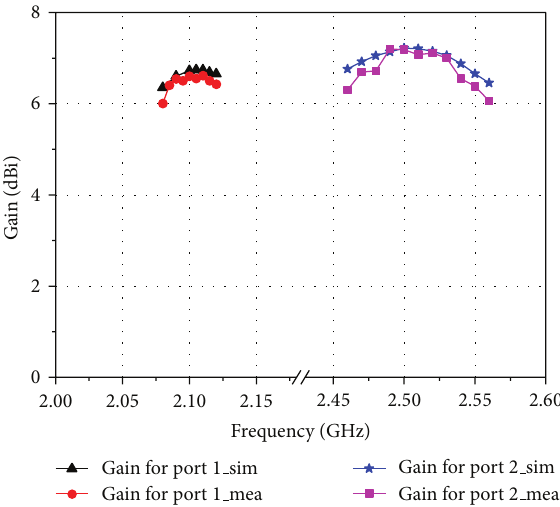
Figure 9: Measured and simulated gains of proposed